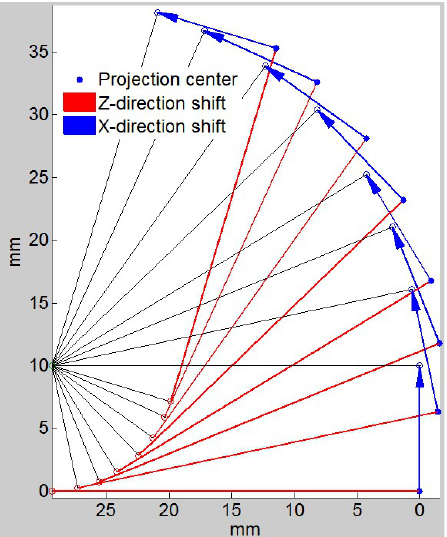
Figure 8. Geometry to determine the Y translation for the concentric imaging in the case of the non-motorized mount.